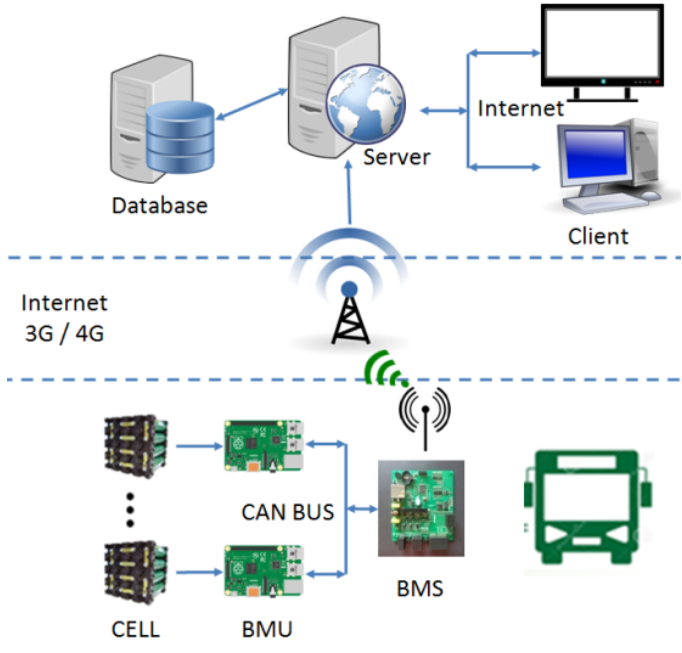
Figure 2. Data transmission flow of the battery management system (BMS).